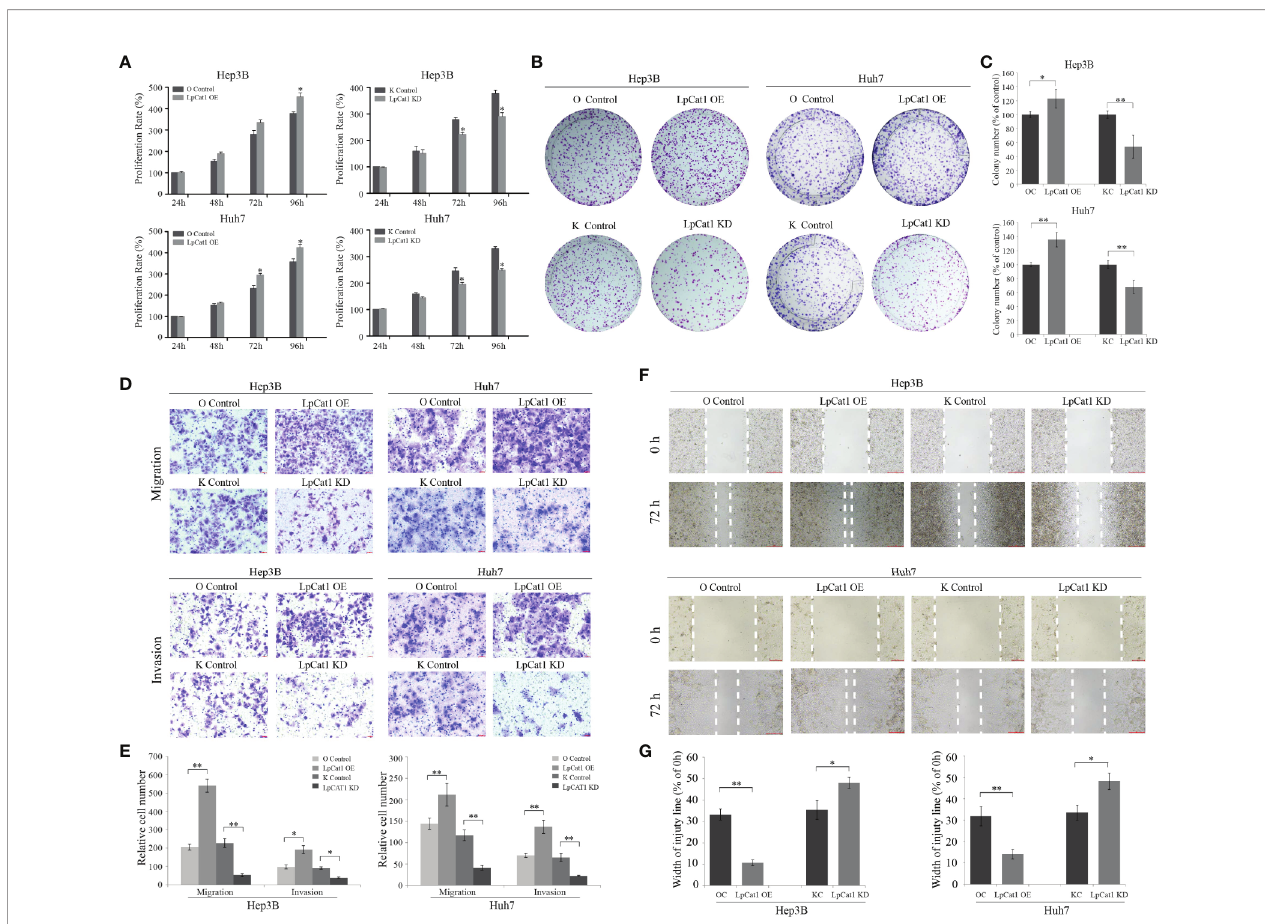
FIGURE 2 | LpCat1 promoted the proliferation, migration and invasion of HCC cells. (A) The proliferative ability of Hep3B and Huh7 cells after stably transfection was evaluated by CCK8 assay. (B, C) Neoplastic capacity of Hep3B and Huh7 cells transfected with over-expression or knockdown vectors of LpCat1 was assessed by plate colony formation assay. Cell colonies were counted and analyzed, then showed in histogram. (D, E) Representative images and quanti fi cation of transwell assays indicated the migration and invasive capability of HCC cells stably transfected with LpCat1 over-expression or knockdown vectors. The penetrated cells were counted and analyzed, and showed in histogram. (F, G) Wound-healing assays were performed to assess HCC cells migration ability. Wound closure was determined 72 h after the scratch. Data were presented as mean±SD, *p < 0.05, **p <